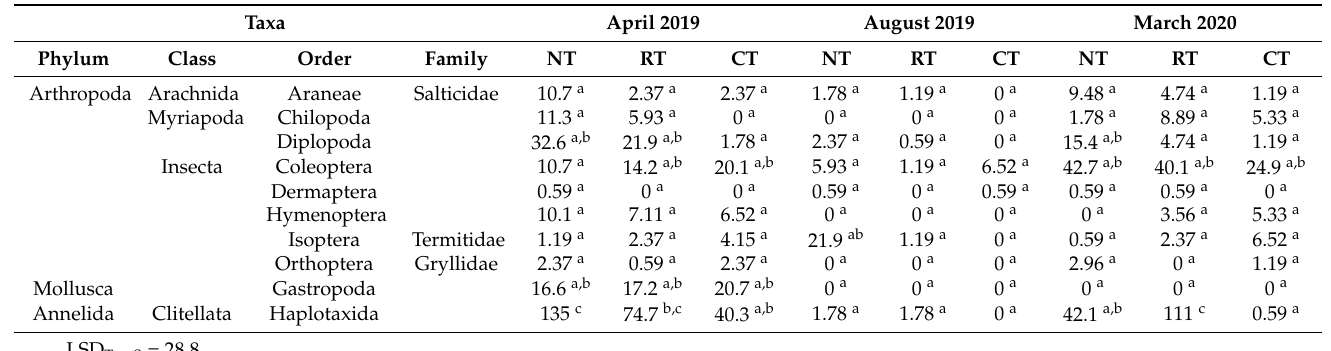
Table 5. The list of taxa, mean abundance (ind.m − 2 ) of soil macrofauna collected from different tillage treatments and at different sampling times.